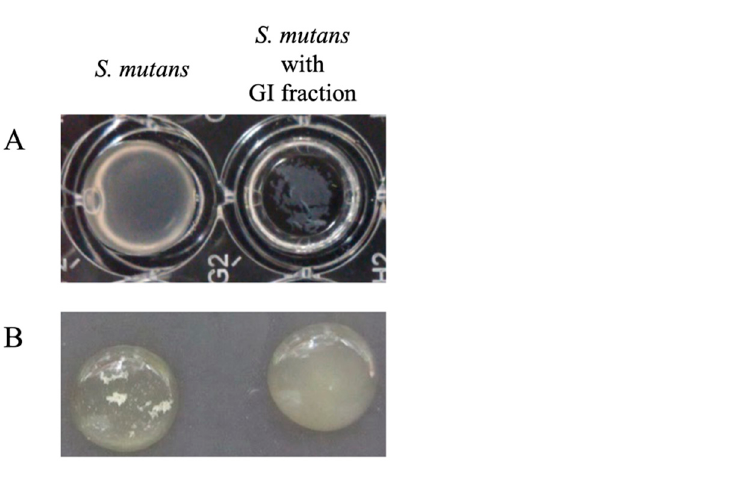
Figure 6. Changes in S. mutans cultivation by adding a GI fraction. Streptococcus mutans was cultured in the presence or absence of a GI fraction through static cultivation using a 96-well plate ( A ) or shaking cultivation using test tubes ( B ). The GI fraction inhibited S. mutans from generating the biofilm-like solid substance on the bottom of a 96-well plate, and cell aggregation of the bacterium was also eliminated by adding the GI fraction in the case of shaking cultivation.